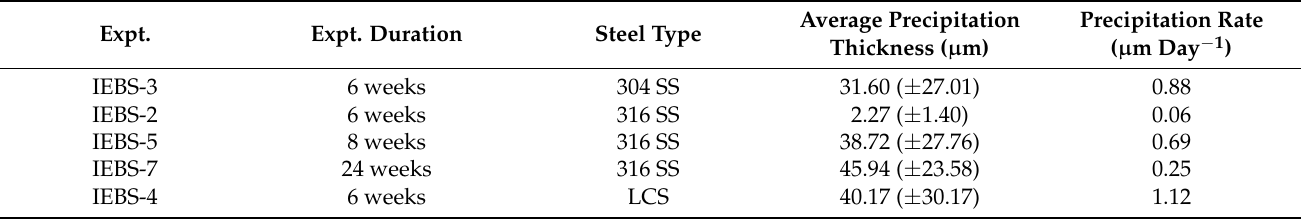
Table 4. Secondary precipitation thicknesses and growth rates at steel surfaces. SS = stainless steel; LCS = low-carbon steel.